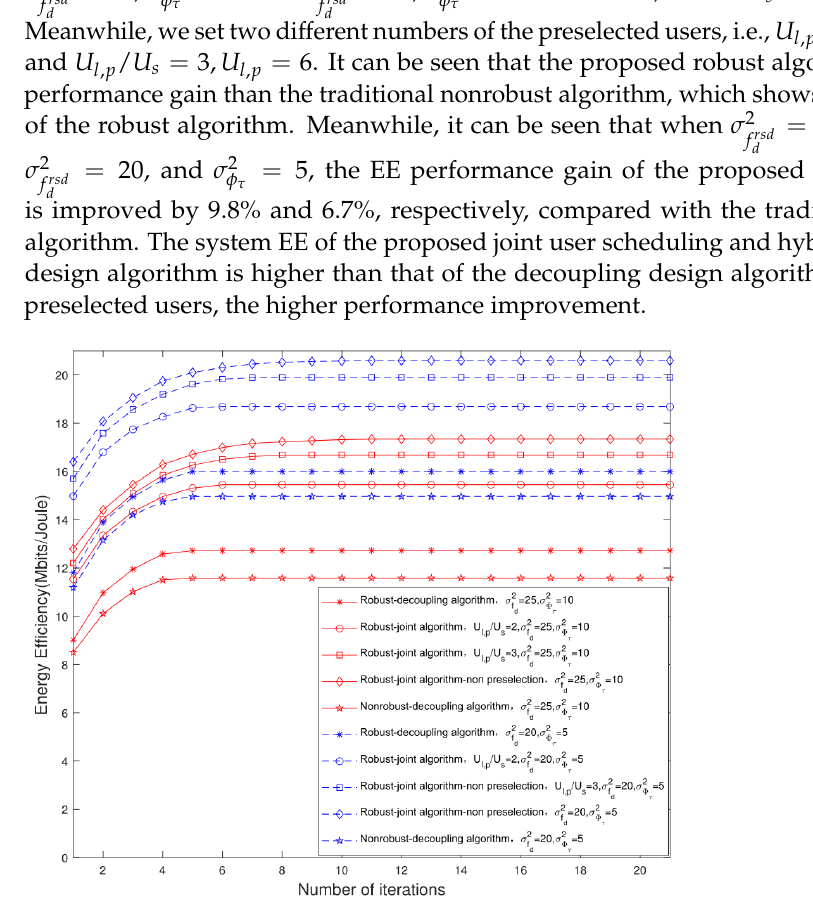
Figure 7. Convergence trajectory of system EE relative to different CSI errors, different number of preselected users and different scheduling algorithms.